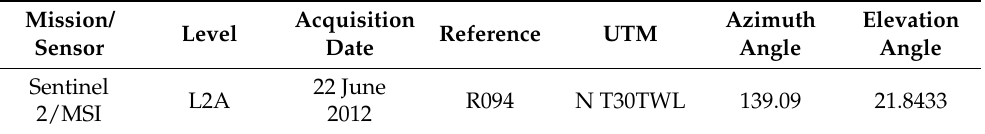
Table 1. Sentinel-2 imagery